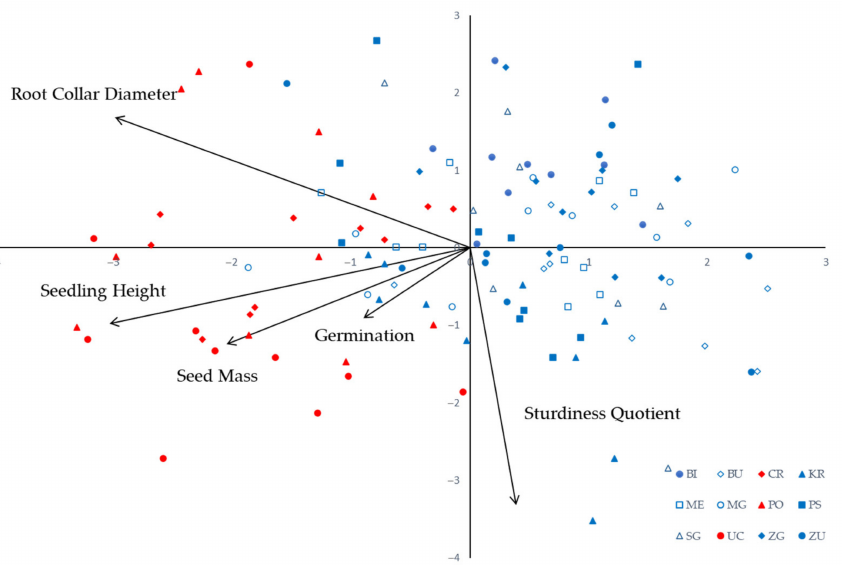
Figure 1. Biplot of principal component analysis based on seed mass, gemination and seedling characteristics in the 12 studied sweet chestnut populations. Population ID: BU—Buje; CR—Cres; PO—Poreˇc; UC—Uˇcka; BI—Bilogora; KR—Krndija; ME—Medvednica; MG—Moslavaˇcka gora; PS—Psunj; SG—Samoborsko gorje; ZG—Zrinska gora;